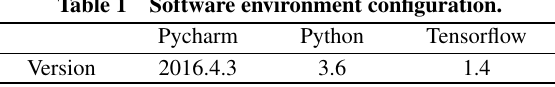
Table 1 Software environment configuration.